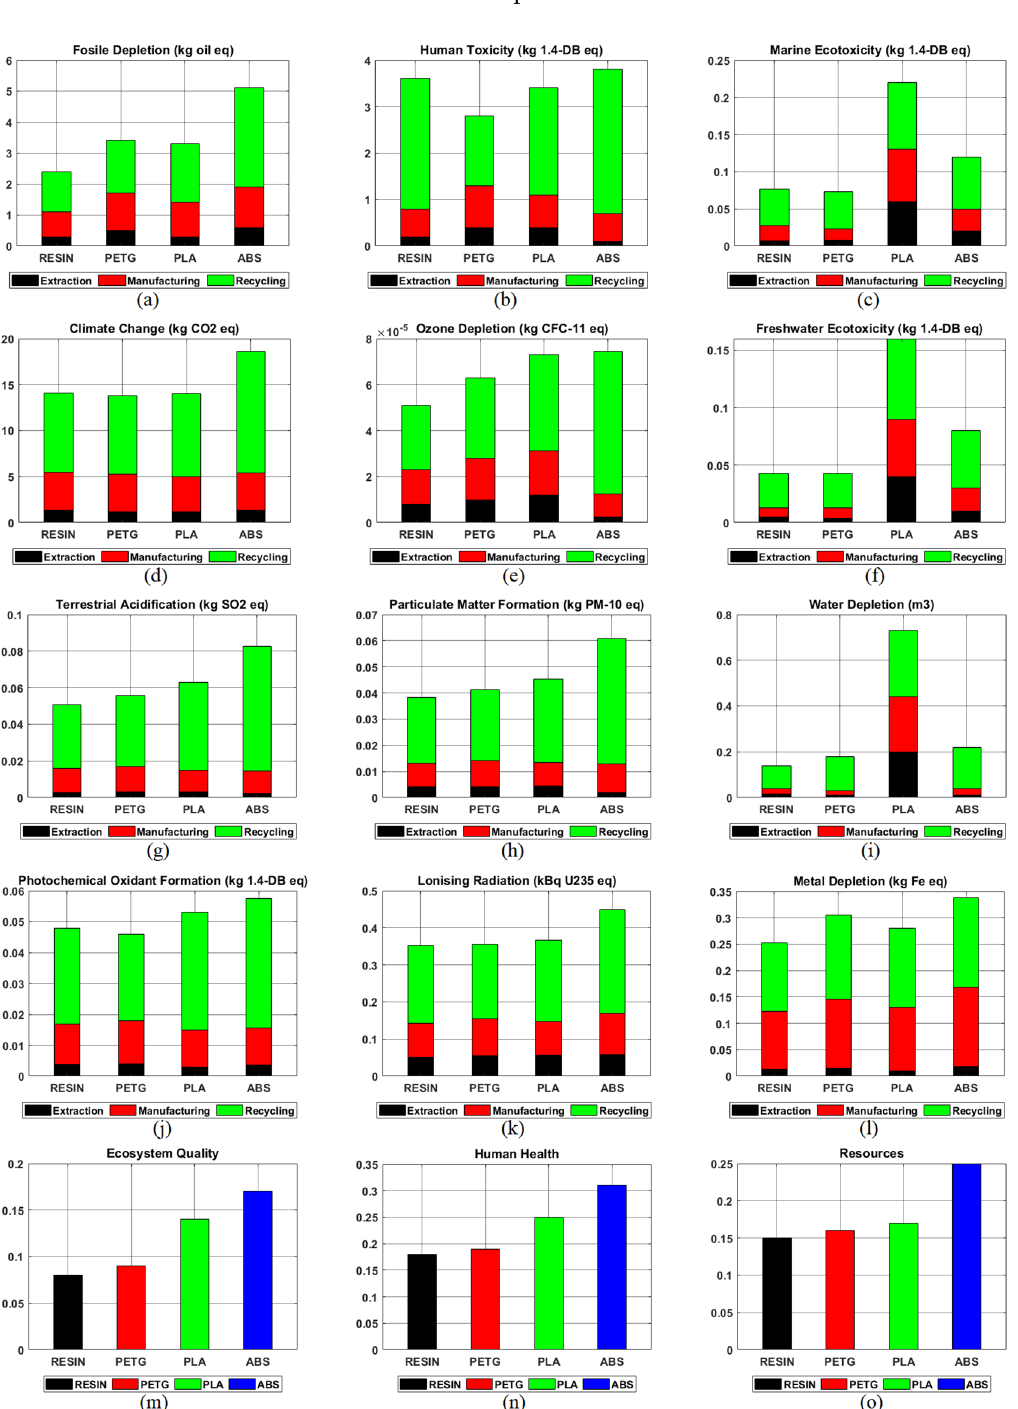
Figure 5. Mid − point and end − point indicator results in the lifecycle assessment process ( a ) Fossil depletion ( b ) Human toxicity ( c ) Marine ecotoxicity ( d ) Climate change ( e ) Ozone depletion ( f ) Freshwater ecotoxicity ( g ) Terrestrial acidification ( h ) Particulate matter formation ( i ) Water depletion ( j ) Photochemical oxidant formation ( k ) Ionizing radiation ( l ) Metal depletion ( m ) Ecosystem quality ( n ) Human health ( o ) Resources.